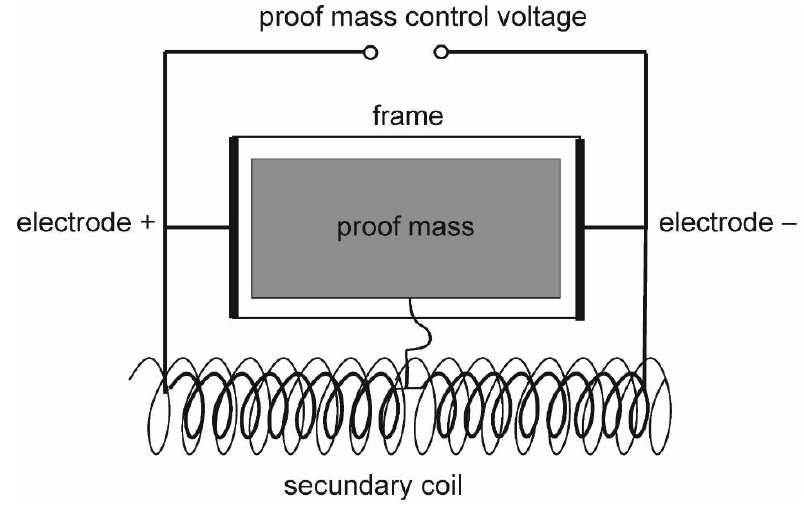
Figure 4. Sketch of one axis of the accelerometer read-out and control. The GRACE accelerometers have two ultrasensitive axes and one less sensitive to ensure testing of the instrument on ground with full gravity acting on the less sensitive axis. The gaps between the proof mass and electrode are about 100 µm small. On the GRACE mission, 10 Hz accelerometer data of all three axes are available. Table 1 summa- rizes the specification of the accelerometer axis. Table 1. SuperSTAR accelerometer specification.